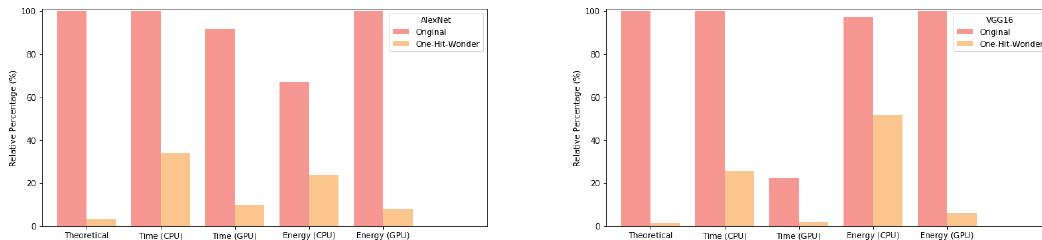
Figure 11. Comparison of layers between original and pruned version of both AlexNet and VGG16 on the UC Merced dataset.